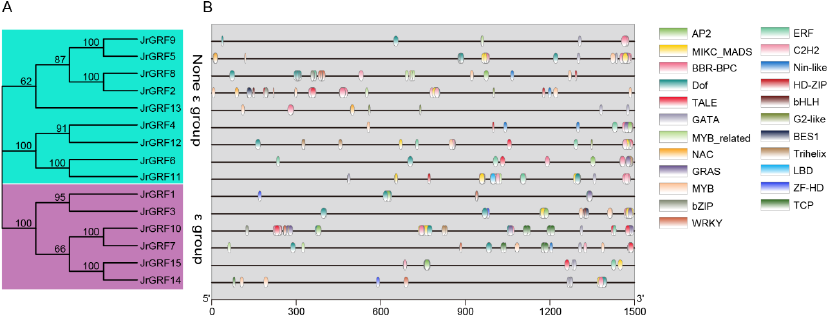
Figure 8. Analysis of JrGRF gene transcription factor binding sites. Phylogenetic relationship ( A ), and Transcription factor binding sites of JrGRFs (B).